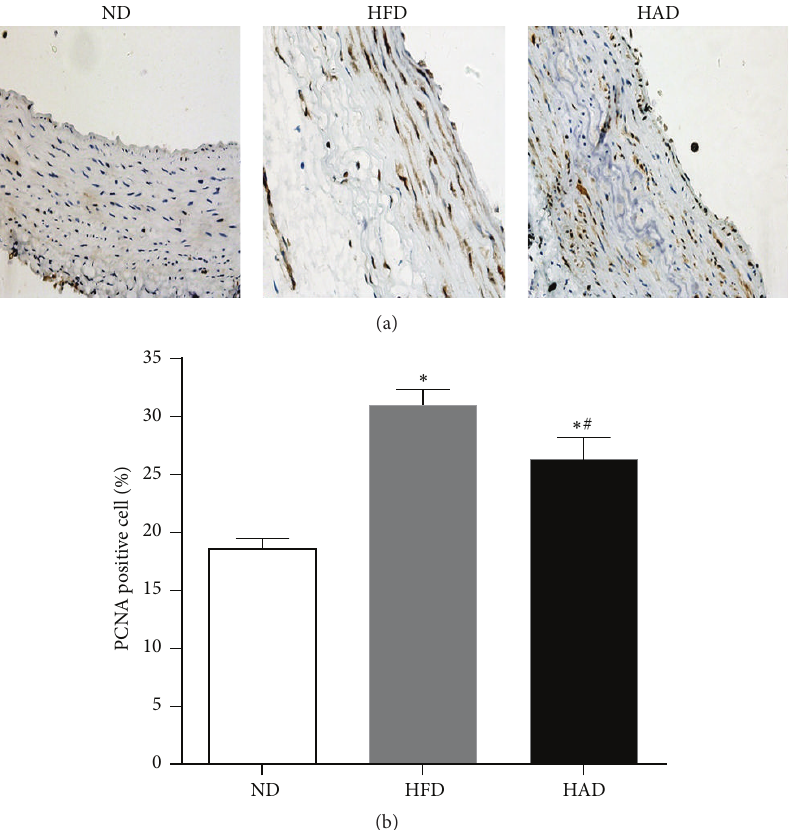
Figure 3: Immunohistochemical staining of aorta in rats. (a) Immunohistochemical staining for PCNA in the aorta ( × 400 magnification). (b) PCNA protein levels were quantified in each group (𝑛 = 6) . ∗ 𝑃 < 0.05 , compared with the ND group; # 𝑃 < 0.05 , compared with the HFD